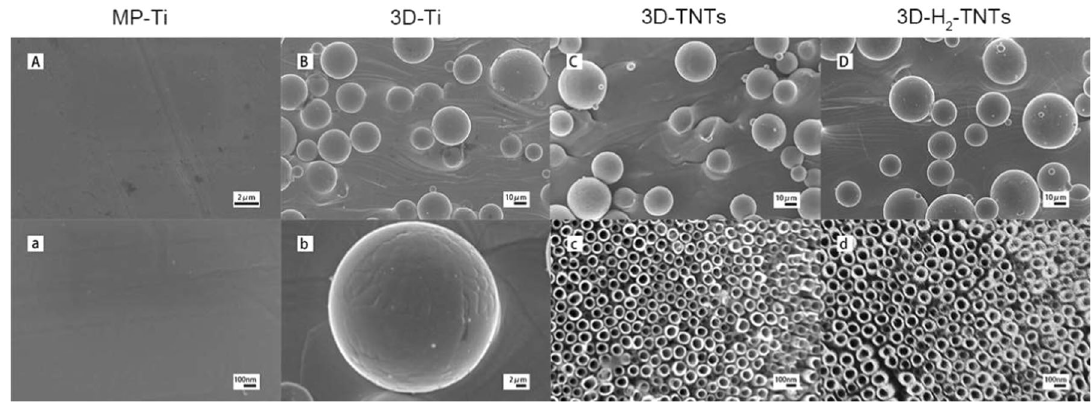
magni fi cation (×500), ( c ) the 3D-TNTs at high magni fi cation (×50,000); ( D ) the 3D-H2-TNTs at low magni fi cation (×500), ( d ) the 3D-H2-TNTs at high magni fi cation